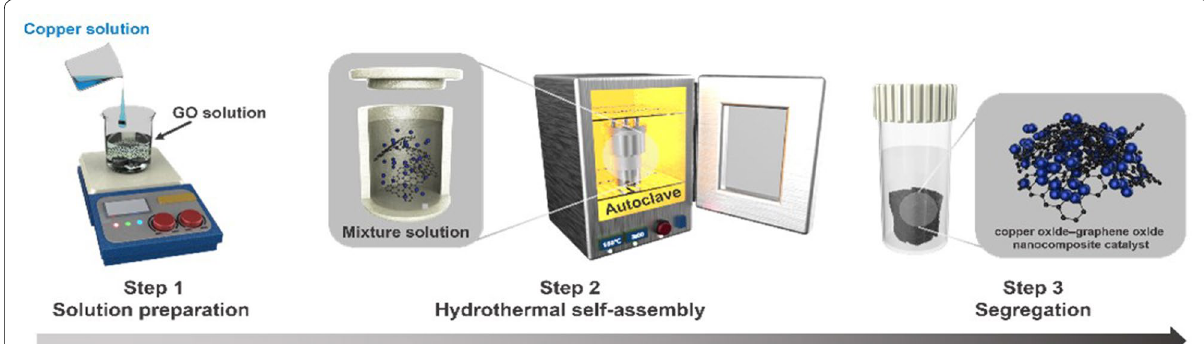
Fig. 1 Schematic illustration for the synthesis of the CuO–GO nanocomposite catalyst